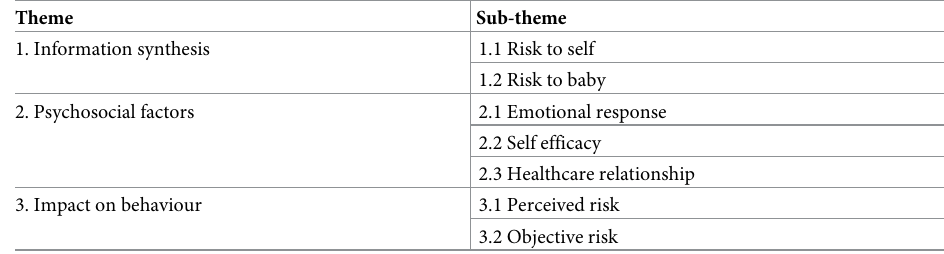
Table 2. Overview of themes and